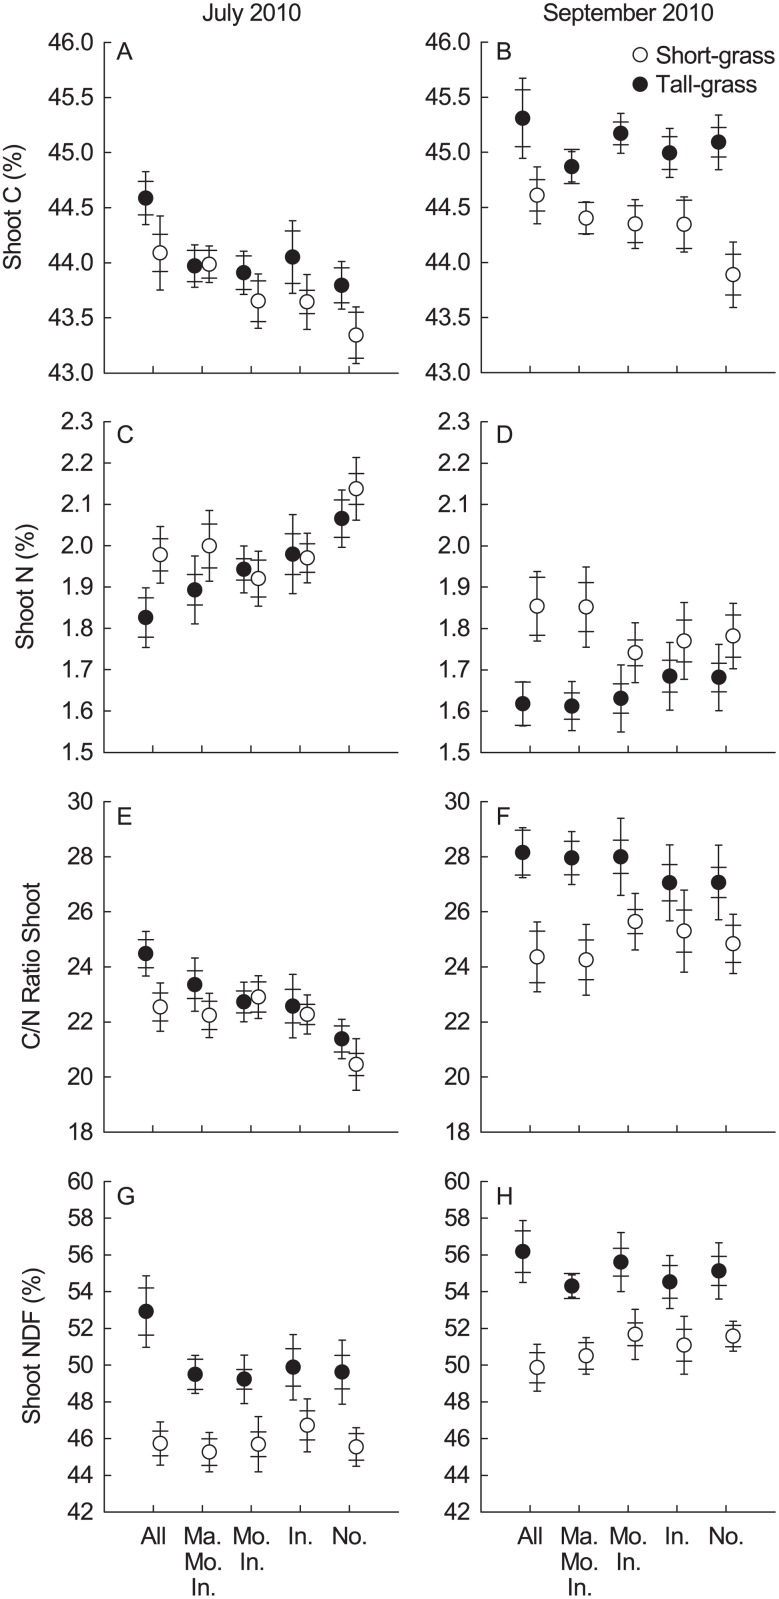
Effects of herbivore exclusion in short- and tall-grass vegetation on A,B) shoot C content (%), C,D) shoot N content (%), E,F) shoot C/N ratio, G,H) Shoot NDF (%). Left panels: July 2010, right panels: September 2010.Treatment abbreviations: “Ma. Mo. In.”- Marmot/Mouse/Invertebrate; “Mo. In.”- Mouse/Invertebrate; “In.”-Invertebrate; “No.”- None. Mean ± Cousineau-Morey SE (wide cap—normalised per exclosure setup for treatment comparisons; narrow cap—normalised per grassland for vegetation type comparisons).